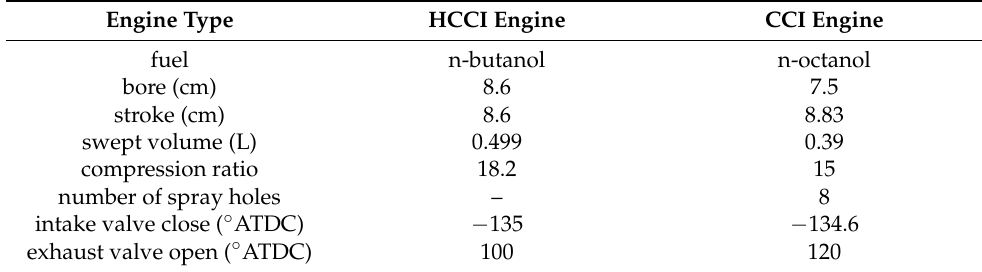
Table 1. Engine specifications [17,22].